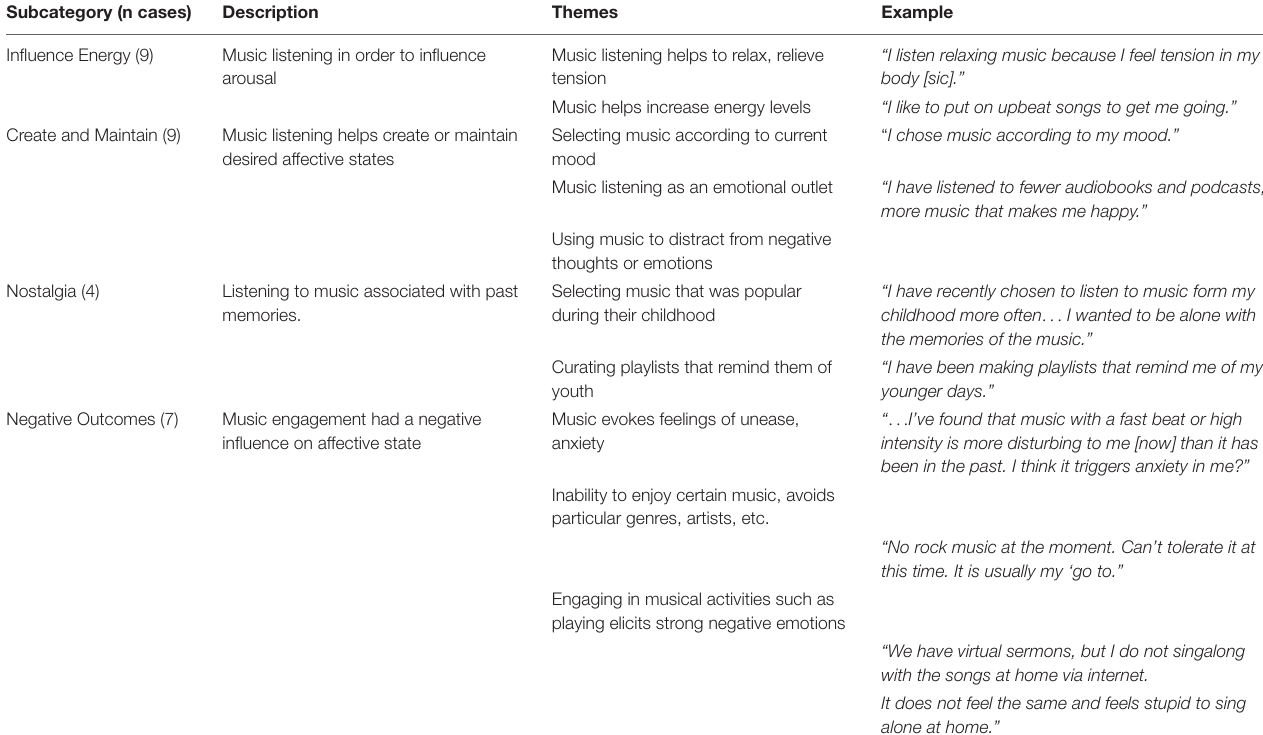
TABLE 6 | Subcategories related to mood